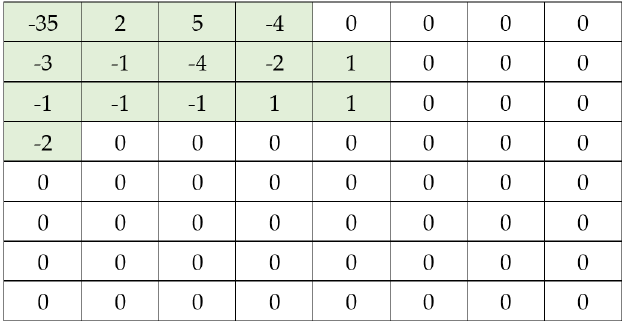
Figure 7. The DCT coefficients.